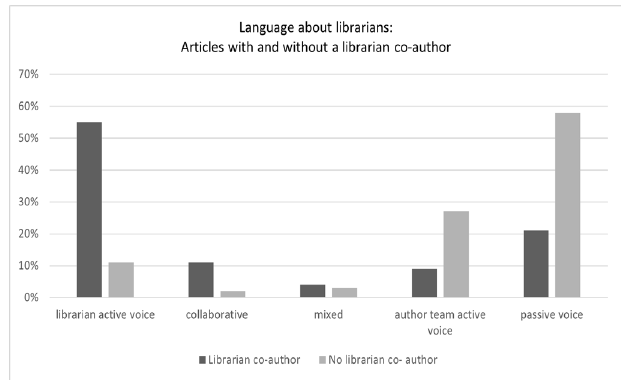
Figure 3 Language about a librarian’s